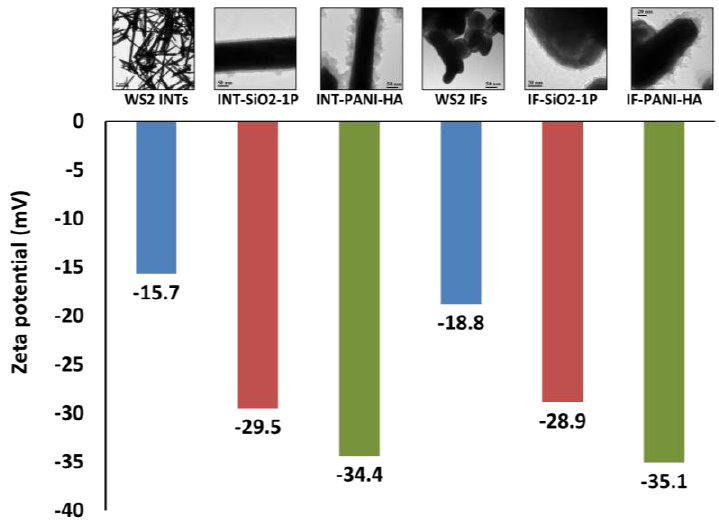
Figure 7. Zeta potentials for aqueous dispersions of bare WS 2 INTs, WS 2 IFs and their composites.